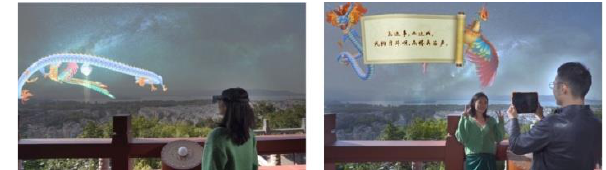
Fig. 3. Application of AR in Tourism-Scenic AR